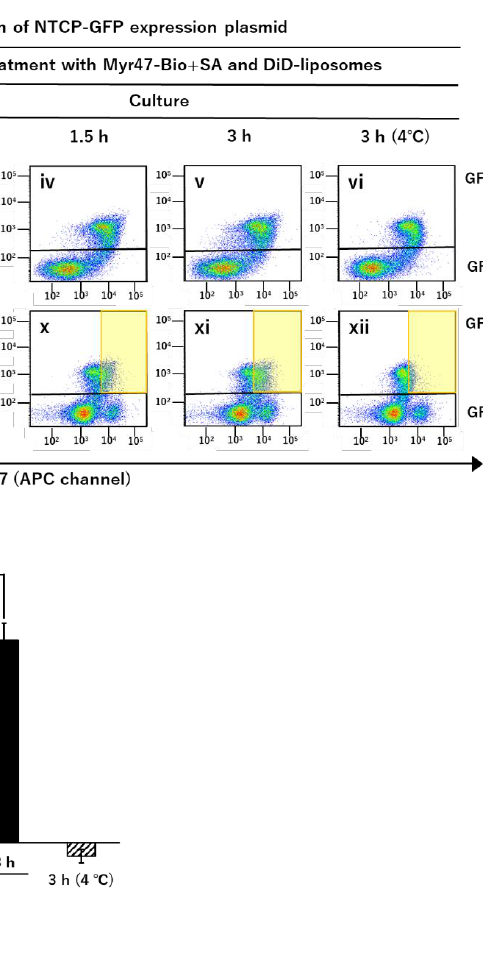
Figure 9. Detection of cell population endocytosing DiD-liposomes using flow cytometry and trypan blue. ( a ) HEK293T cells transfected with or without (untransfected) an NTCP-GFP expression plasmid were treated with or without (untreated) Myr47-Bio+SA followed by DiD-DOPC/PEG-Bio (10%). Subsequently, they were cultured for the indicated time. Then, they were subjected to flow cytometry. Upper and lower row panels indicate two-parameter dot plots obtained in the absence or presence of 0.1% trypan blue, respectively. The red area gated in panel (ix) was defined here as the GFP + cell population whose fluorescence derived from DiD-liposomes bound to the cell surface was quenched by trypan blue. The blue area gated in panel (iii), which corresponds to the red area gated in panel (ix), represents the GFP + cell population emitting the fluorescence of DiD-liposomes bound to the cell surface in the absence of trypan blue. The yellow gated area in panels (x~xii) cor- responds to that in red in panel (ix). Cell culture was completed at 37 °C (iv/x) and (v/xi) or 4 °C (vi/xii). To obtain dot plot data, we analyzed 30,000 cells. ( b ) Cell populations in the gated areas in panels (ix~xii) were quantified and expressed as percentages which were calculated by the formula: (%) = [cell population in the gated area of the panel (ix~xii) — that of the panel (ix)]/[that of the panel (iii) — that of the panel (ix)] × 100. The assay was completed in triplicate and data were expressed as mean values ± SD (vertical bars). ** p < 0.01 in Student’s t -test.